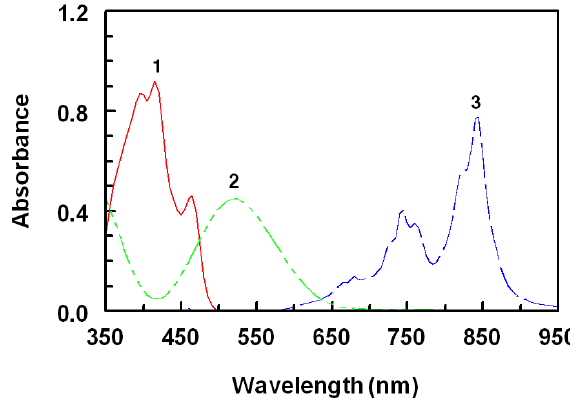
Figure 4. Absorption spectra of the CT complexes of ROS-Ca with TCNE (1), pCA (2), and TCNQ (3). Concentrations of ROS-Ca were 50, 70, and 20 μ g mL − 1 in case of TCNE, pCA, and TCNQ, respectively. Solutions were prepared in acetonitrile for reaction with all acceptors.